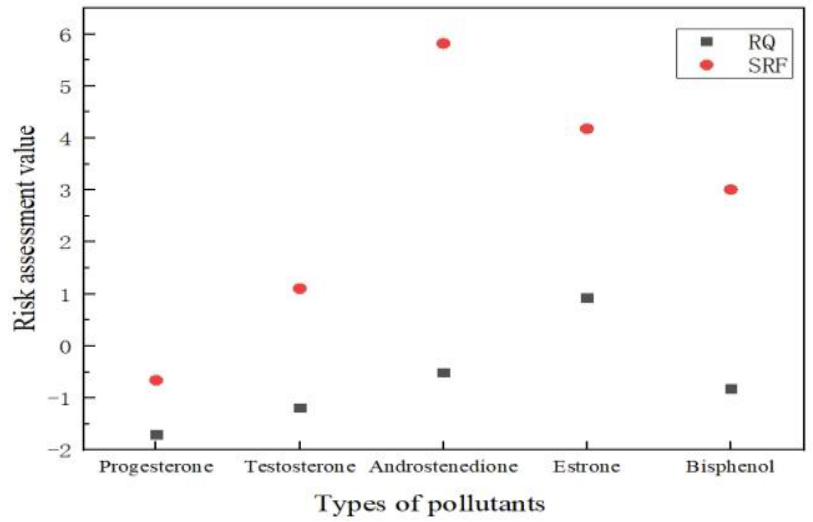
Figure 4. Environmental risk level assessment of endocrine disruptors using RQ and